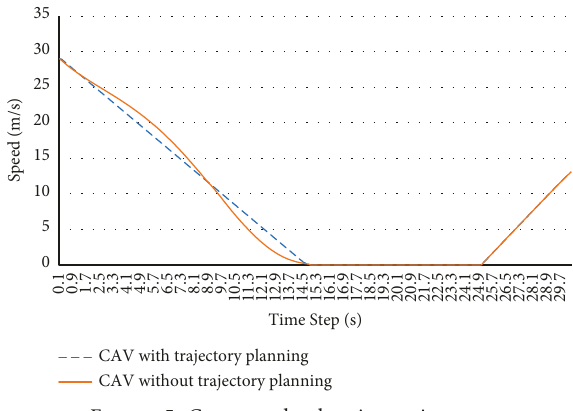
Figure 5: Constant deceleration trajectory.